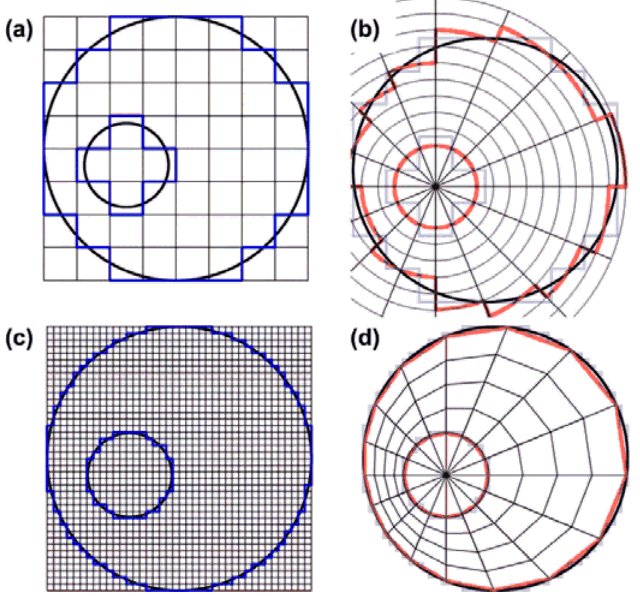
Figure 2. ( a ) Schematic drawing of the rectangular displacement grid as obtained from a linear array transducer; ( b ) Boundary discontinuities appear when projecting the data directly on a polar grid; ( c ) Upsampling and subsequent interpolation on the vascular finite element grid; ( d ) avoids boundary discontinuities to appear at the